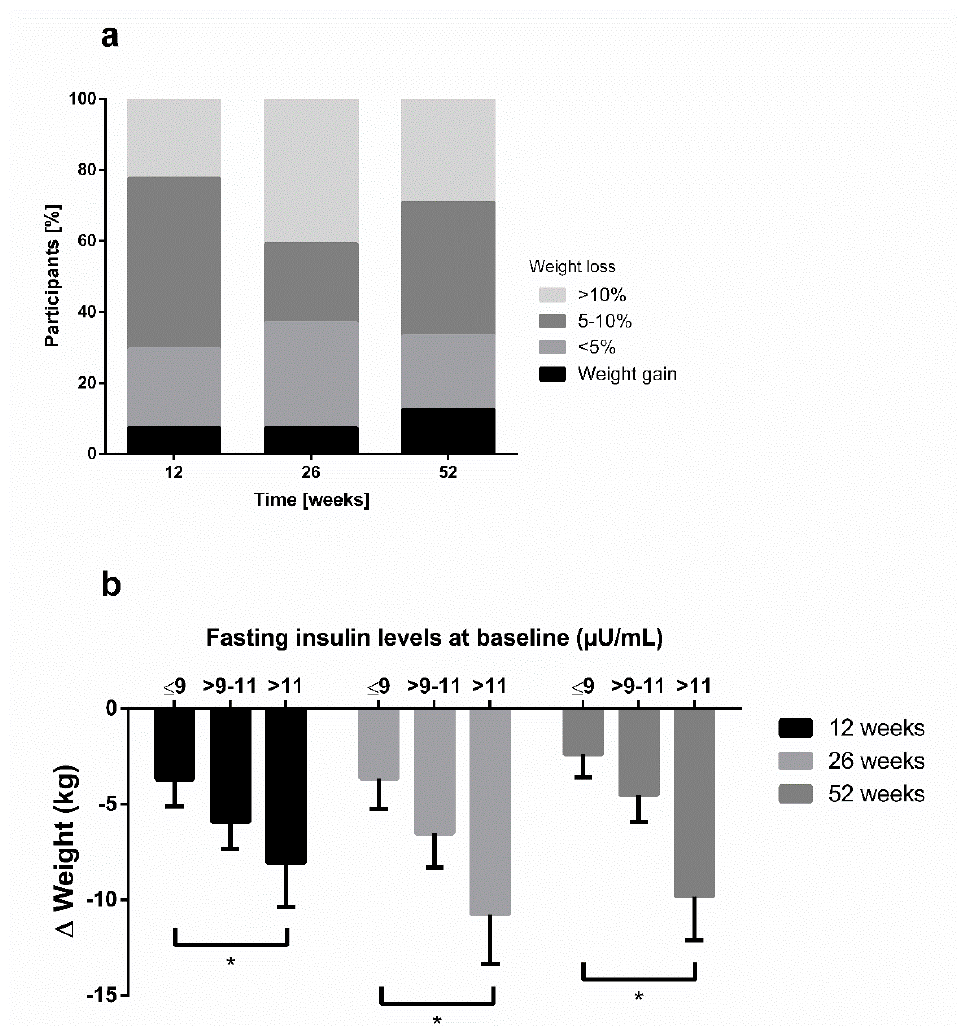
Figure 3. Changes in body weight of the total sample. PP-analysis with n = 25. ( a ) Frequency of categories of weight changes throughout the study were compared by using χ 2 test (* p < 0.05). ( b ) Tertile stratification in baseline fasting insulin levels for weight changes in all three groups after 12, 26, and 52 weeks. Multivariable regression analyses were performed to investigate group differences and were adjusted for baseline values and multiple testing. * p < 0.05.